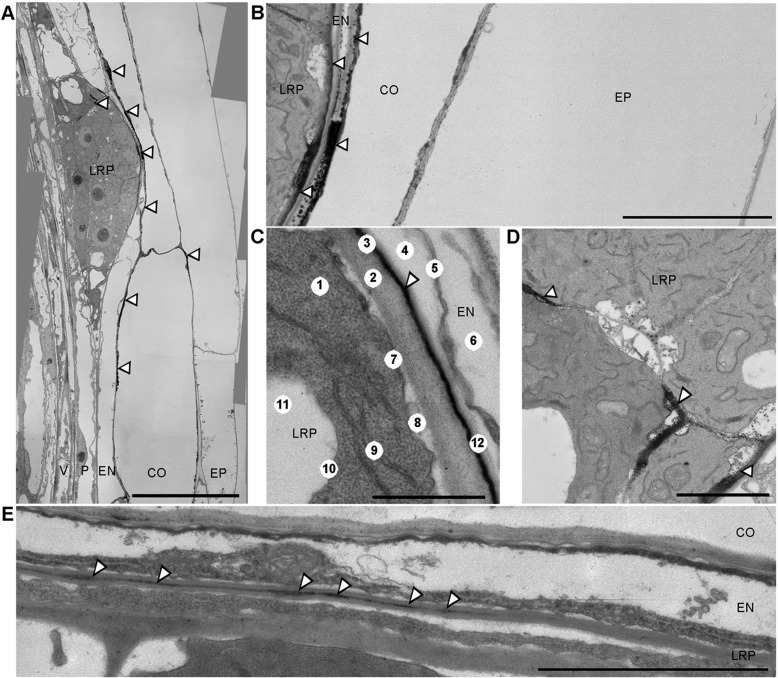
Representative transmission electron microscopic images of Arabidopsis LRP treated with cerium chloride to visualize localization of H2O2 by black cerium depositions. (A-D) H2O2 localization during LR emergence in outer cells (B), between LRP and endodermis (C), and between flanking cells inside the LRP (D). (E) H2O2 localization in LRP at stage II of development in middle lamellae between outer cells of LRP and endodermis, as the LRP is passing through endodermis. B and D are magnified views of A. CO, cortex; EN, endodermis; EP, epidermis; LRP, lateral root primordium; P, pericycle; V, vasculature. Numbers in C indicate (1) cytoplasm, (2) cell wall of outer LR cell, (3) middle lamella, (4) periplasmatic space, (5) remnants of endodermis protoplast, (6) vacuole, (7) plasma membrane, (8) periplasmatic space, (9) endoplasmic reticulum, (10) tonoplast, (11) vacuole and (12) cell wall of endodermis cell. Scale bars: 20 μm (A); 6 μm (B); 2 μm (C-E). Magnifications: 1200× (A); 4000× (B); 12,000× (C-E). White arrowheads point to the cerium depositions. n=15.